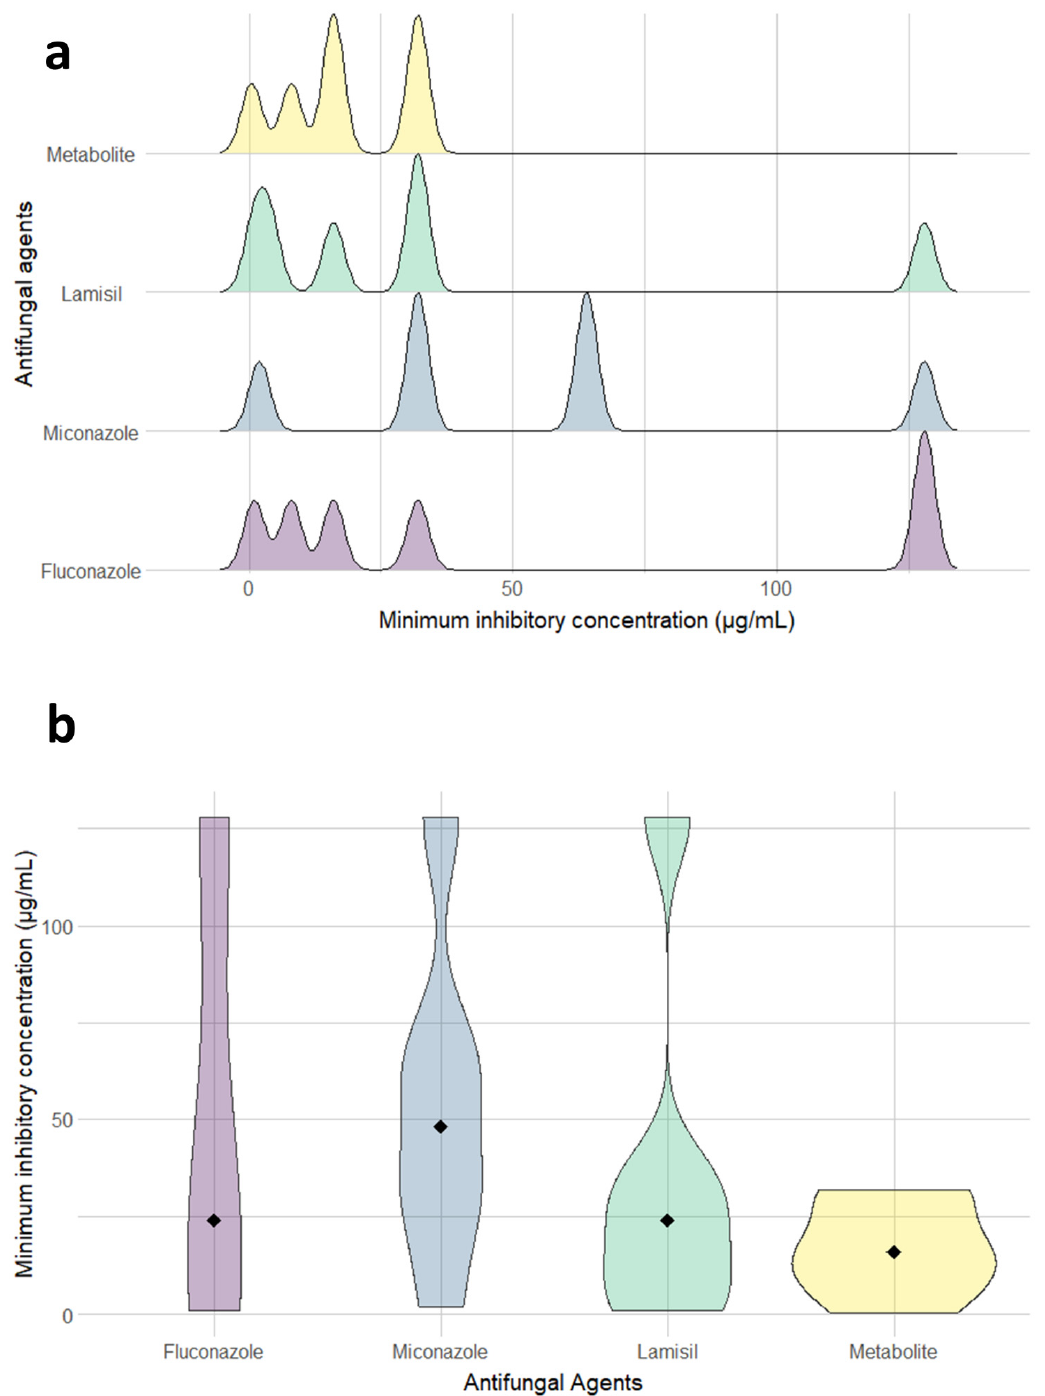
Figure 4. ( a ) Ridgeline plots showing the distribution of minimum inhibitory concentrations ( µ g/mL) for fluconazole, miconazole, Lamisil and the metabolite against six isolates of C. albicans. Area under the ridgeline is plotted after calculation of density estimates from the provided data. Plot was created by R (“gg ridges”) package. ( b ) Violin plots representing the kernel probability density of C. albicans isolates at different values of the minimum inhibitory concentrations ( µ g/mL) for fluconazole, miconazole, Lamisil and the metabolite. The filled black diamond signifies the MIC median value allowing better assessment of the data obtained from different antifungals. Plot was created by R (“ggplot2”)